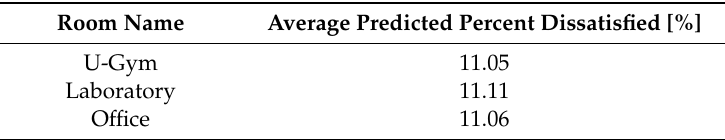
Table 4. Discomfort indicator values.